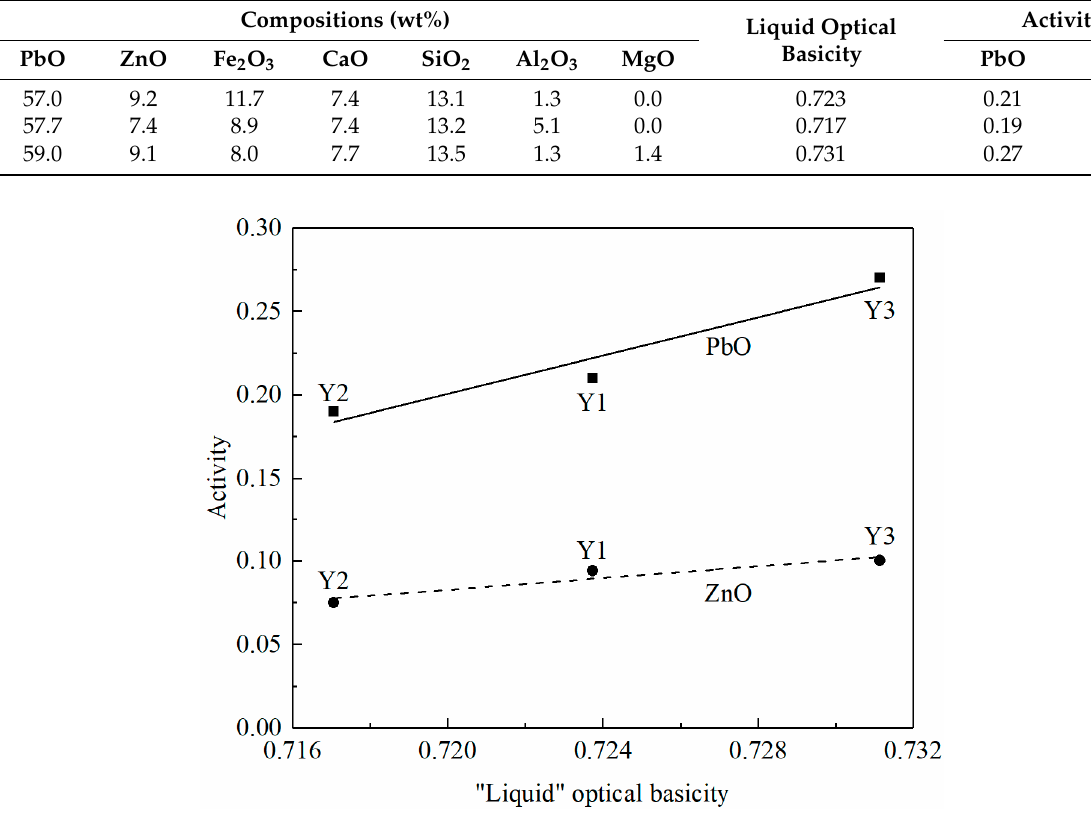
Figure 12. The relationship between optical basicity of liquid slags and the activity of PbO and ZnO at 1473 K.